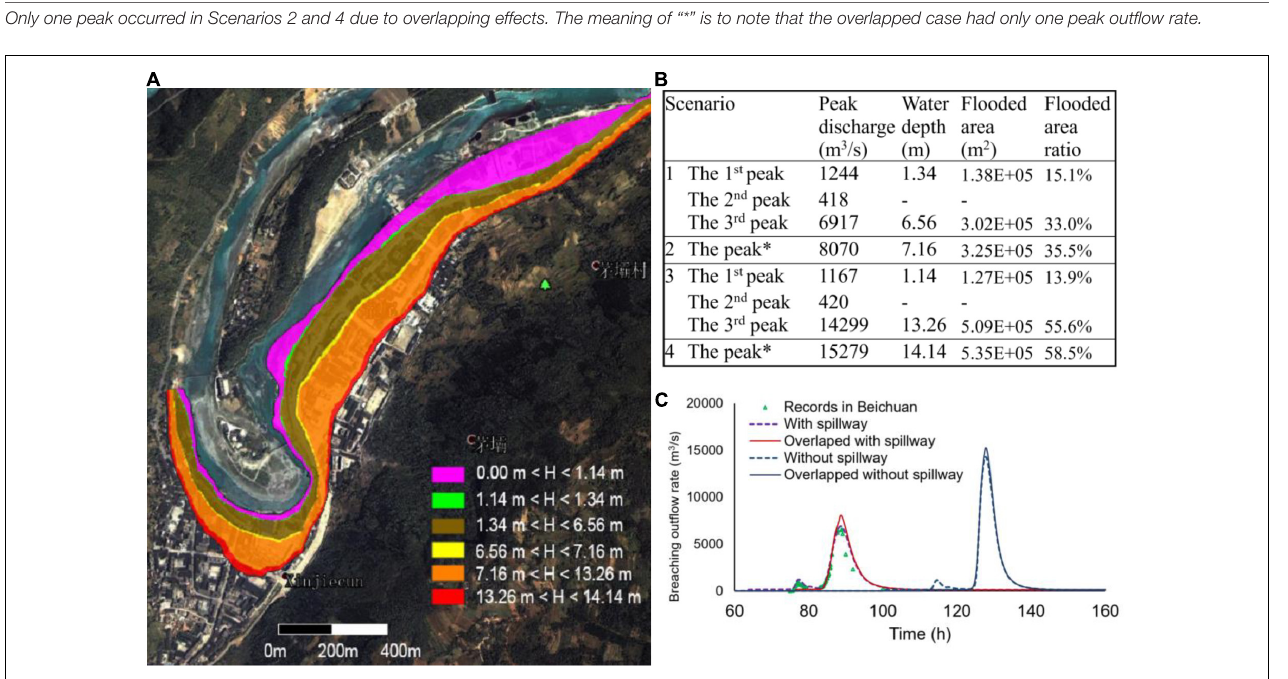
FIGURE 7 | The hydraulic parameters of different scenarios in Beichuan County: (A) the flood inundation map; (B) the peak discharge and the maximal water depth; and (C) the discharge curves along